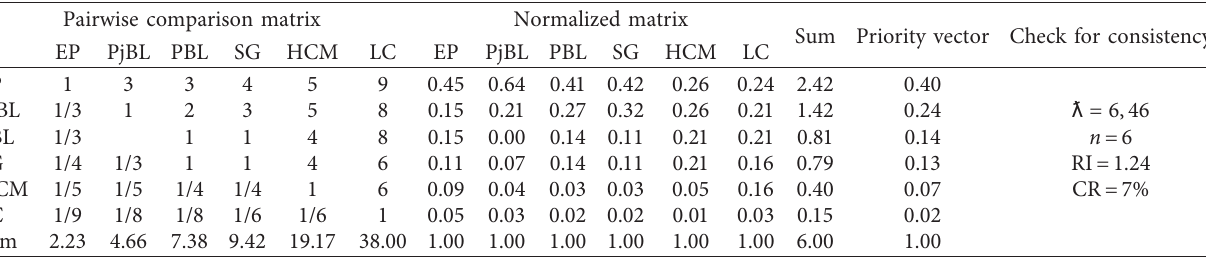
Table 17: Pairwise comparison matrix of learning strategies with respect to the Criterion “SS9. Innovation.” Pairwise comparison matrix